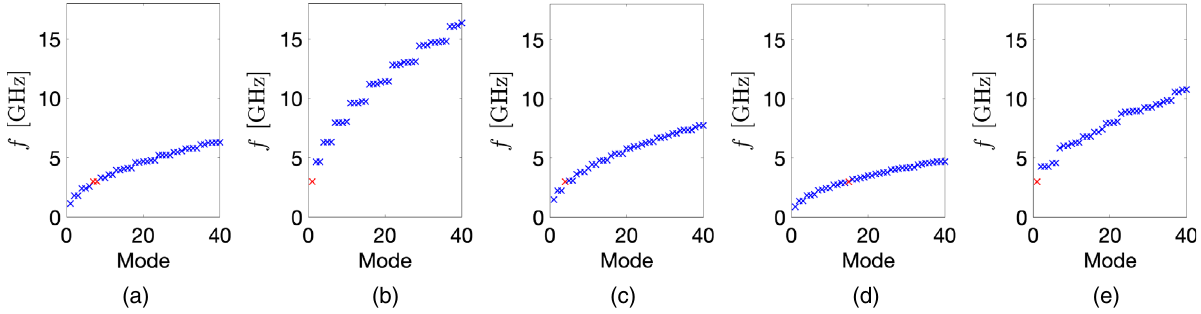
FIG. 8. Frequency spectra of the 40 lowest frequency TM modes for the five different cavity shapes that support the mode denoted in the part caption. The red crosses represent the 3 GHz mode of interest. (a) TM 310 . (b) TM ˜ g ˜ g 0 . 95 . (d) TM , ˜ g 3 = ˜ g 0 ¼ 0 . 95 . (e) TM 3 = 0 ¼ f 0 ; 3 g 30